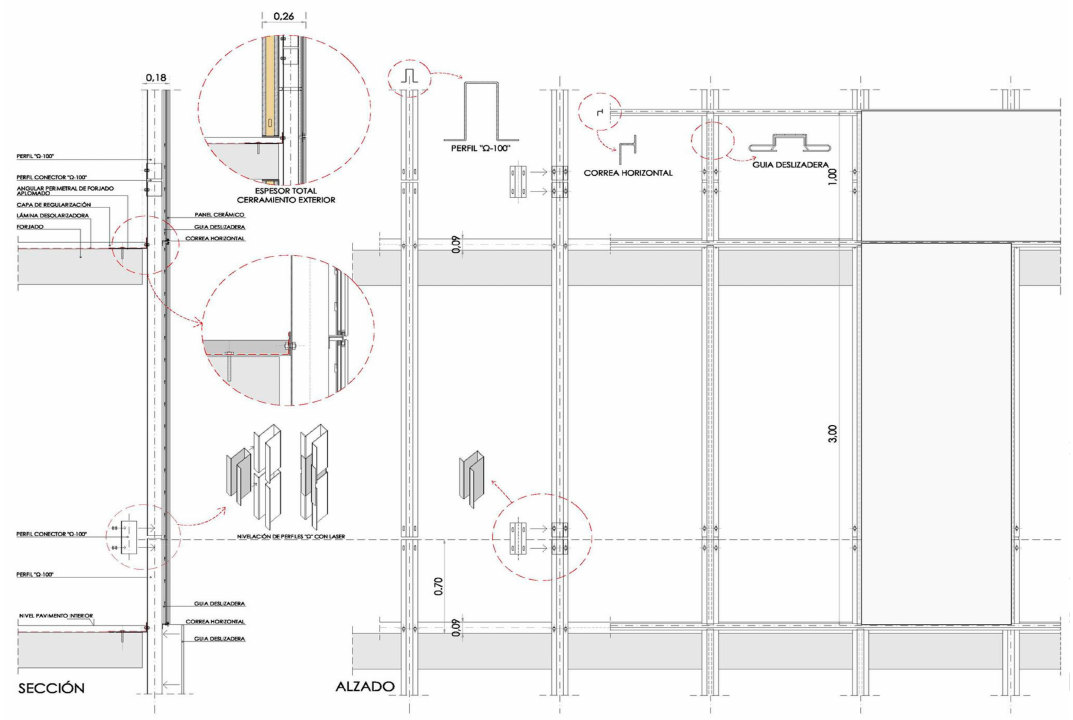
Figure 6. Assembly sequence of the metal structure. Right detail: section of the enclosure that defines a total thickness of 26 cm. Reproduced with permission from reference [2].